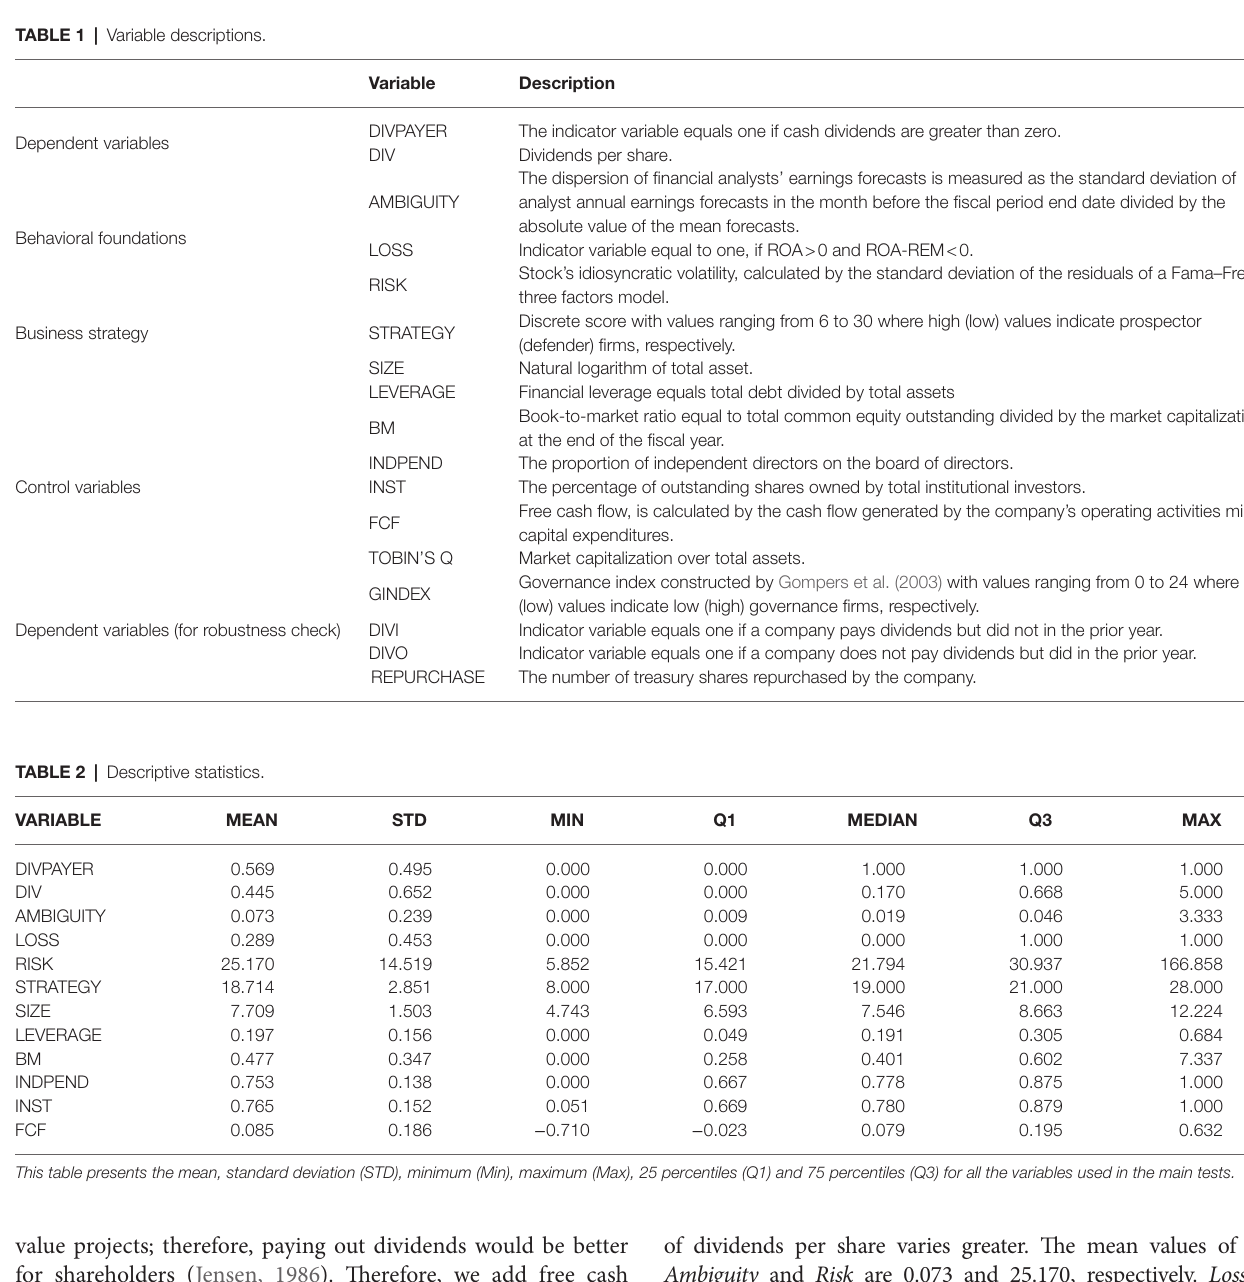
Dependent variables